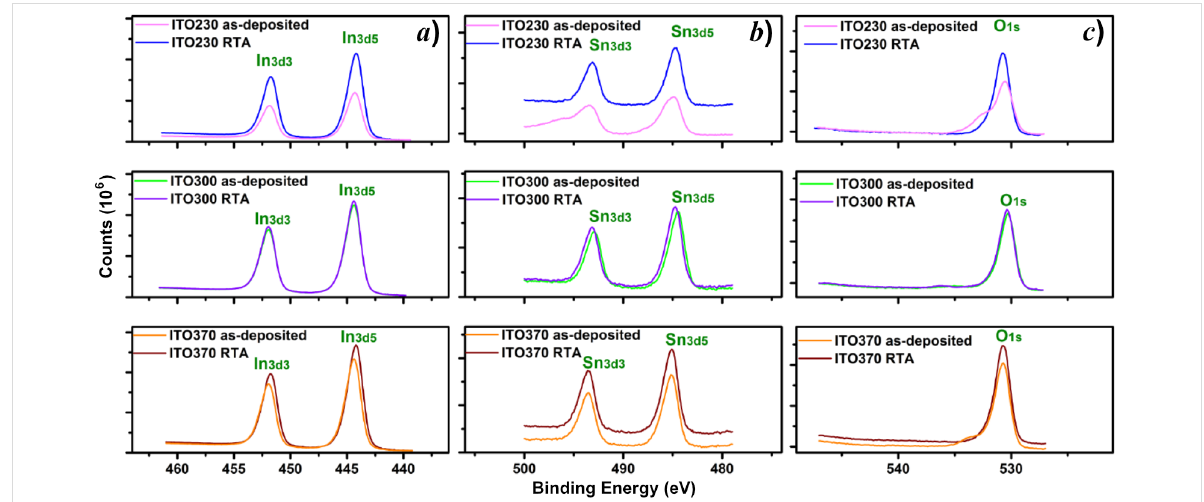
phase appears in a larger quantity for the untreated samples and decreases with increasing thickness (230–370 nm) of the layer for both treated and untreated samples. On the other hand, the amount of Sn oxides decreases for the treated samples. There- fore, it can be concluded that ITO is very stable on the surface of the samples after the application of RTA. Note that XRD did not reveal the presence of a characteristic phase for In 2 O 3 or SnO 2 , but only the ITO